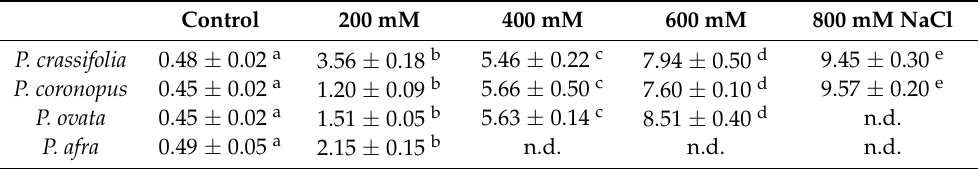
Table 2. Electrical conductivity of the substrate in 1:5 soil:water suspensions (EC 1:5 , dS m −1 ), in pots watered for four weeks with the indicated NaCl concentrations. The values shown are means ± SE ( n = 5). In each row, different letters indicate significant differences between treatments, according to the Tukey test ( p < 0.5). n.d.: not determined.